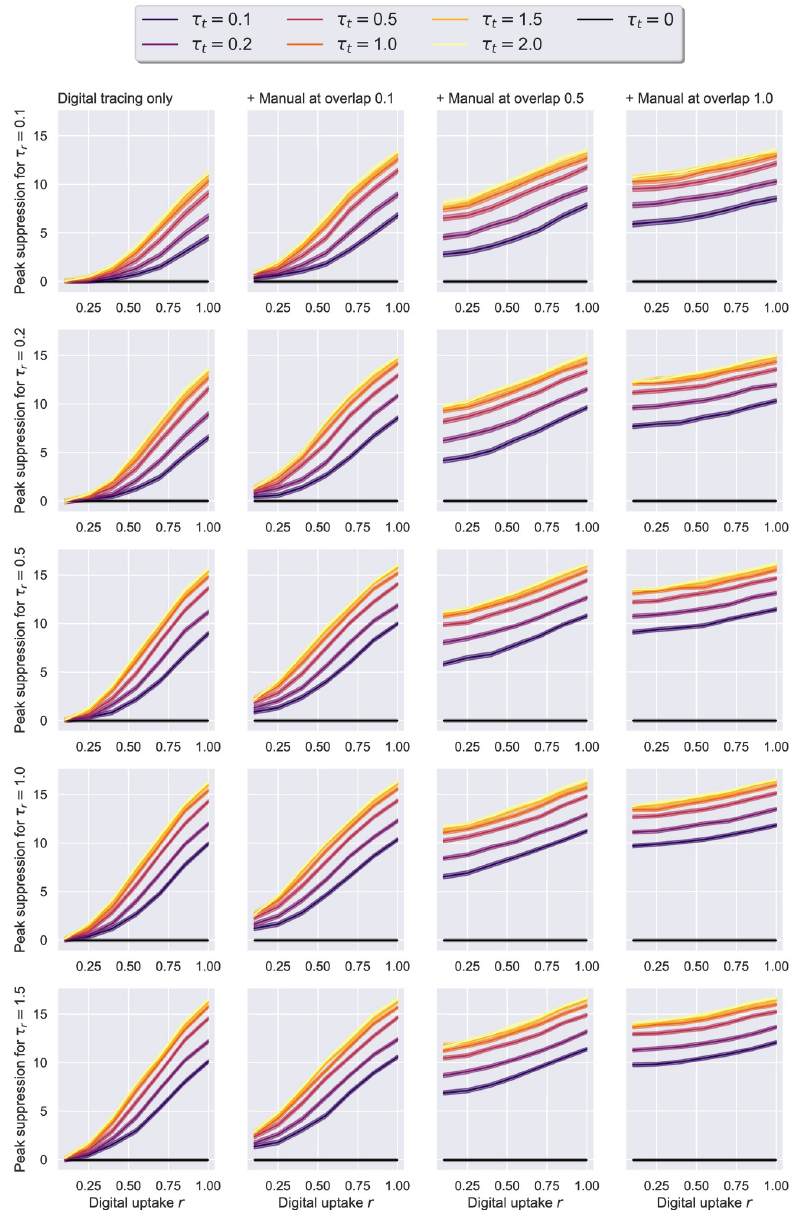
Fig 15. Social evolution—Uptake rate r against peak suppression. Suppression is difference in peak to no tracing, i.e. τ t = 0. The results here correspond to the real Social Evolution network, dynamic over the studied period of 31 weeks, p a = 0.2, η = .001. On the left, we have a scenario in which only digital tracing was conducted, whereas the next 3 columns represent simulations with a combination of digital tracing on a second network, and manual tracing over a third network with various overlaps: 0.1, 0.55, 1. The 95% confidence intervals are displayed. The case with no tracing ( τ t = 0) is colored in